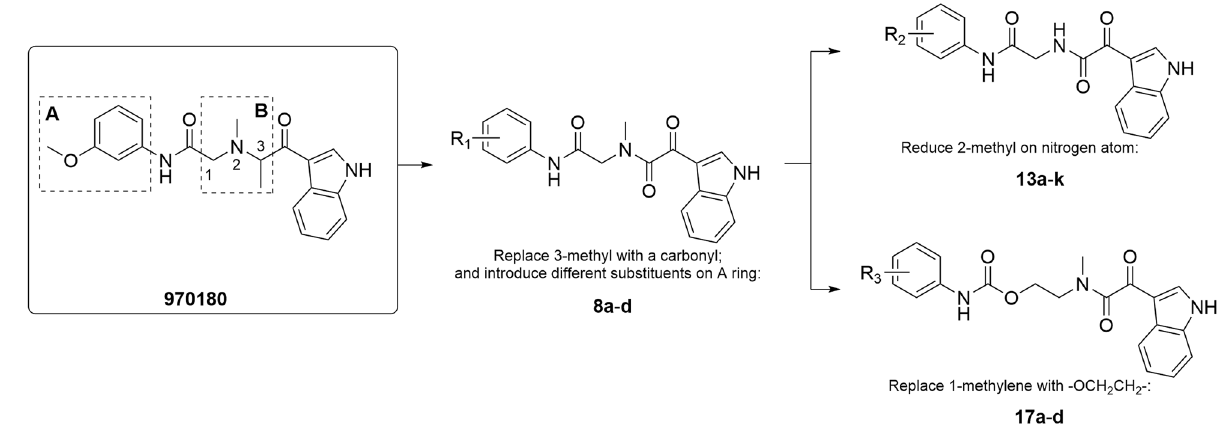
Figure 1. Design strategy carried out starting from 970180